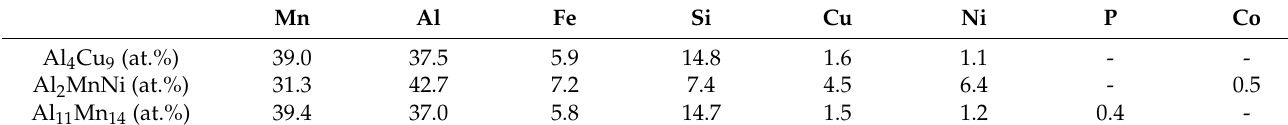
Table 5. Chemical composition of individual phases in sample sintered at 950 °C.